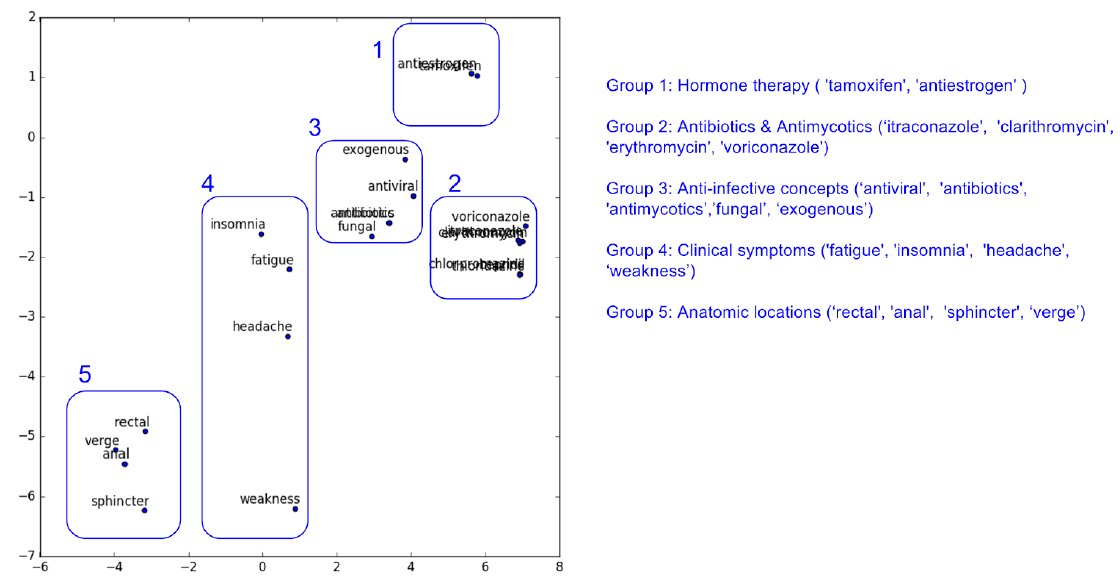
Figure 5. Word-embeddings projected into a reduced space with t-Distributed Stochastic Neighbor Embedding (t-SNE).